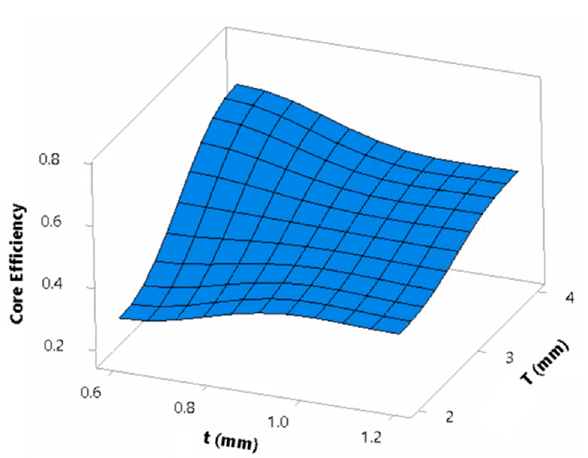
Materials 2020 , 13 , x FOR PEER REVIEW Figure 21. Influence of geometrical parameters on (cid:2013) (cid:3030)(cid:3042)(cid:3045)(cid:3032) . Figure 21. Influence of geometrical parameters on ε core .